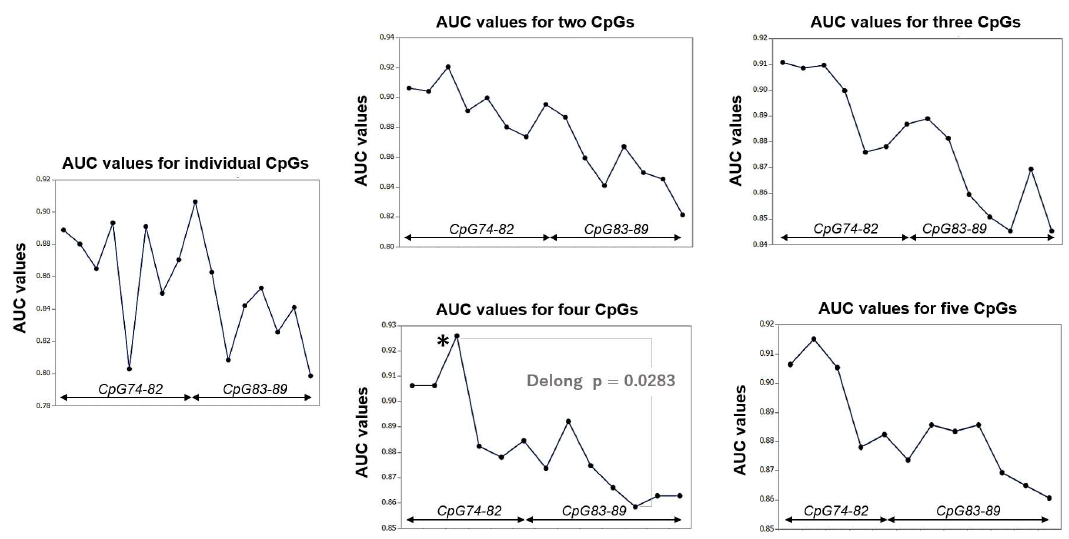
Figure 2. The line graphs show the AUCs at all individual and combined CpG sites, which indicate predictive performance for favorable response (CR or PR) to the adjuvant therapy. AUCs of con- secutive CpG combinations were higher for CpG 74–82 in exon 1 than for CpG 83–89 in intron 1. *: highest value among all combinations